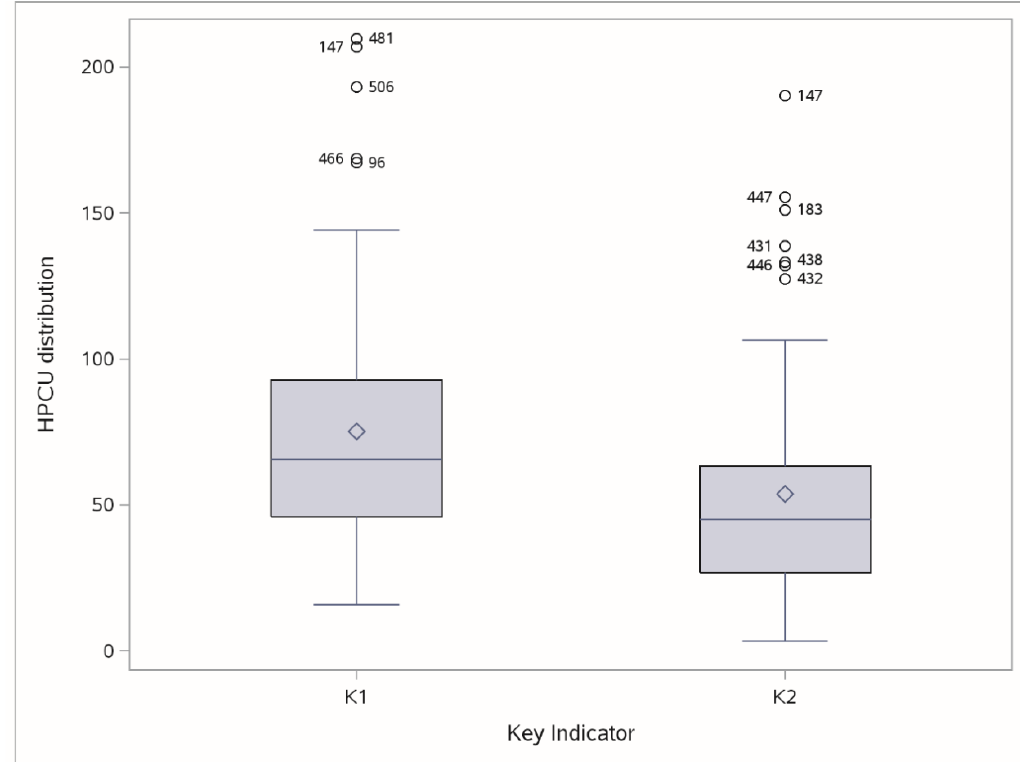
Figure 2. Boxplot of K1 (N = assisted cancer patients × full-time palliative care physician) and K2 (N = assisted cancer patients × full-time palliative care nurse): HPCS IDs labeled as extreme outliers (outside the outer fences).